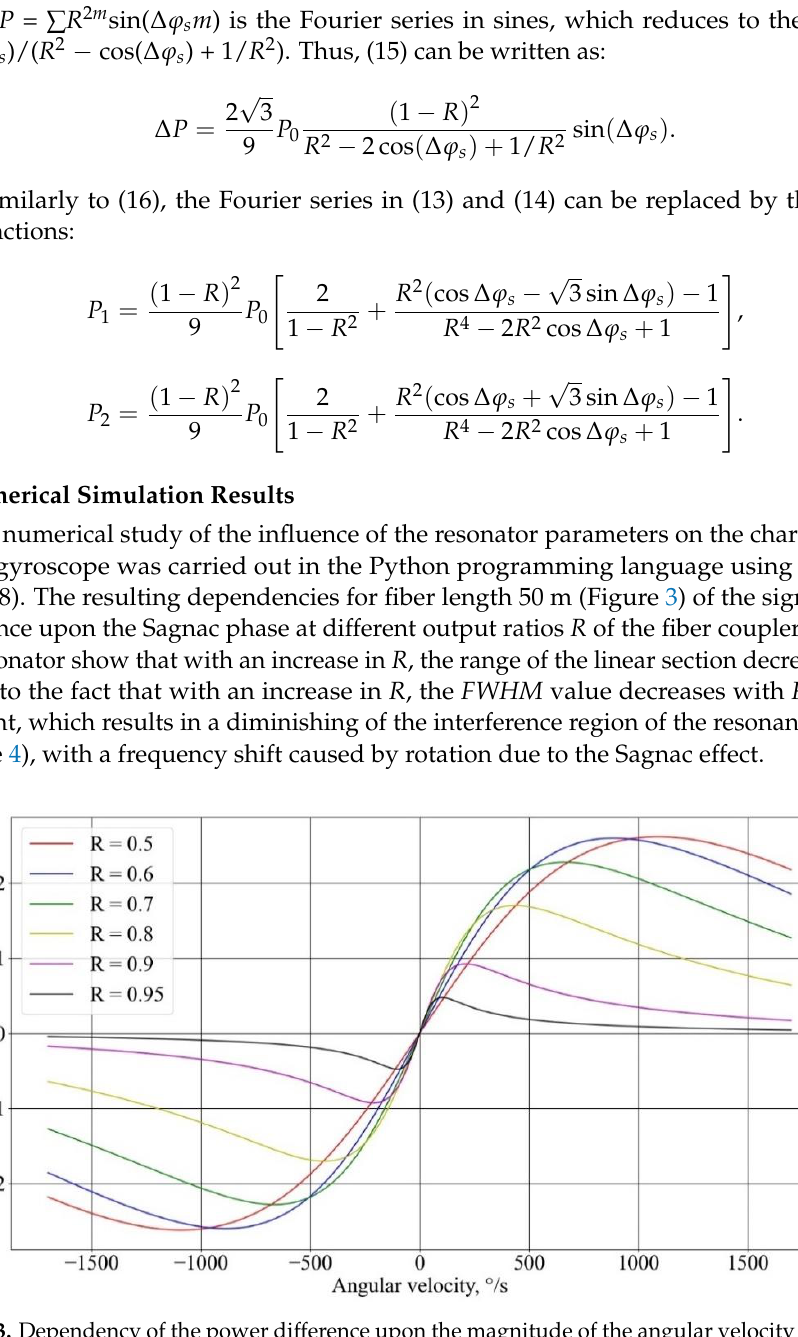
Figure 3. Dependency of the power difference upon the magnitude of the angular velocity at different output ratios of the fiber couplers, forming the resonator.